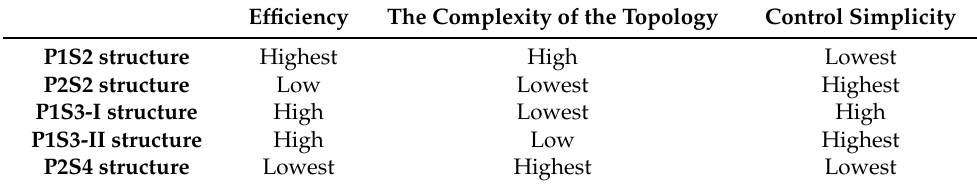
Figure 1. A modified TPC structures with two bidirectional ports based on [18]. Table 1. A comparison between different TPC structures [18].